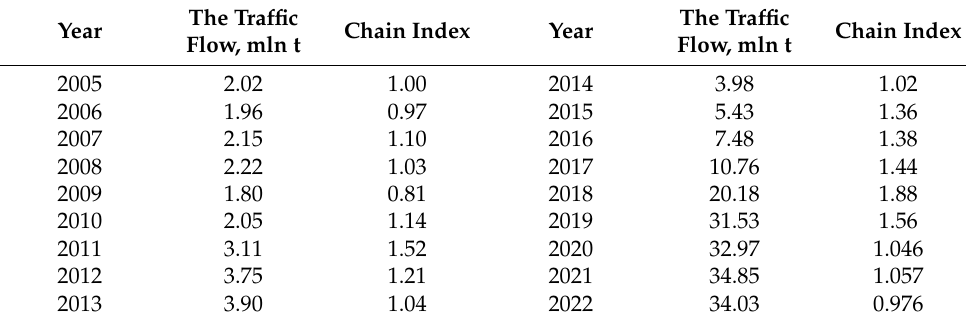
Table 2. The NSR traffic flow from 2005 to